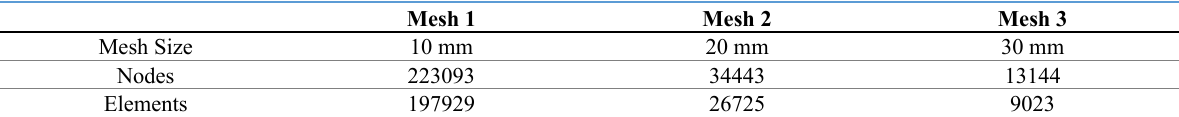
Table 5: Mesh size data for slab (NRC-2) model Mesh 1 Mesh 2 Mesh 3 Mesh Size 10 mm 20 mm 30 mm Nodes 223093 34443 13144 Elements